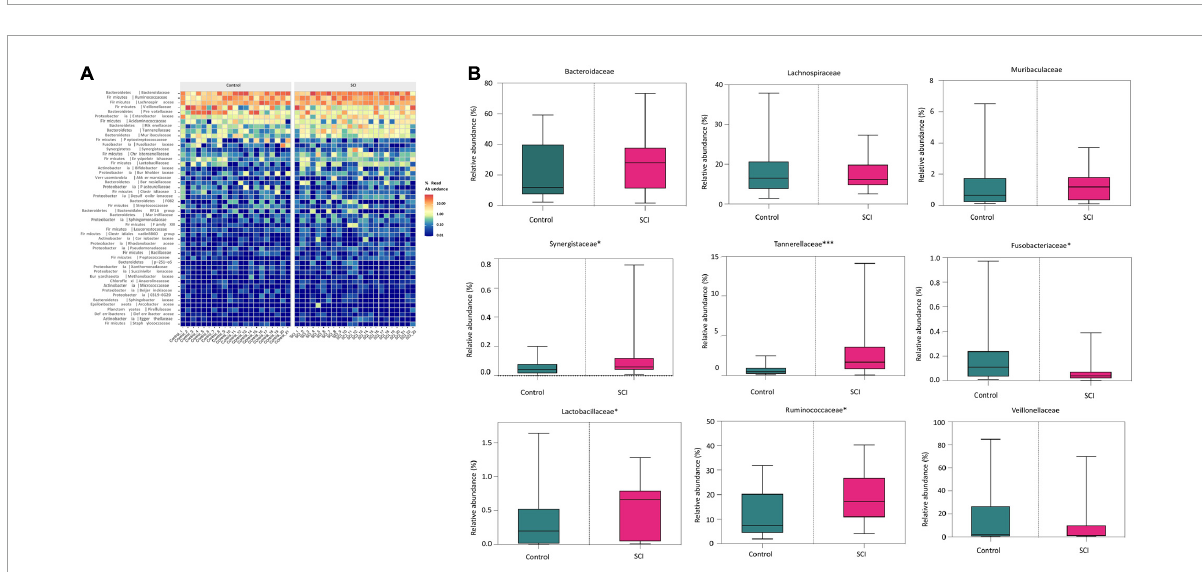
FIGURE4 Analysis of the composition of the gut microbiota at the family level. (A) Heat map of the gut microbiota at the family level. (B) The relative abundance of dominant microbiota at the family level. Each box plot represents the median, interquartile range, minimum and maximum values. Each dot represents a subject. Data was expressed as median (interquartile range); * P < 0.05, *** P <